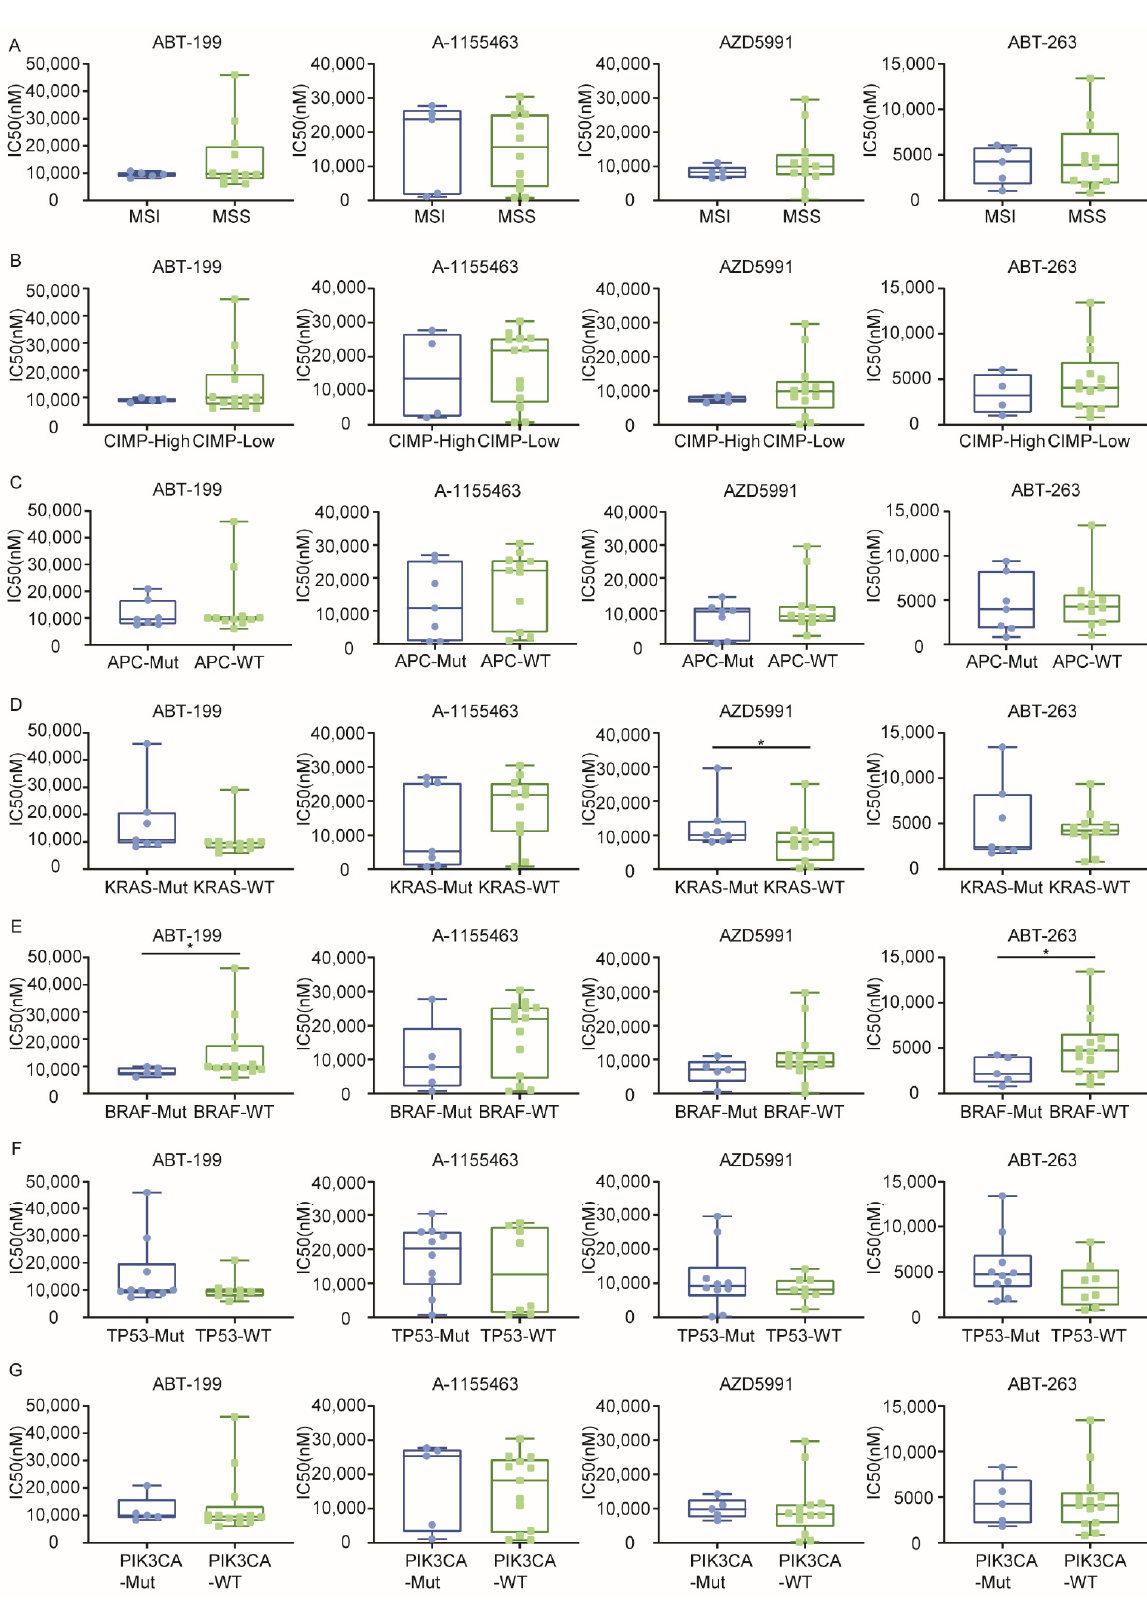
Figure 4. Correlation analysis of IC50 values of four BH3 mimetics and molecular phenotypes in CRCs. ( A ) Microsatellite instability MSI, MSI microsatellite instable; MSS: Microsatellite stable; ( B ) CpG island methylator phenotype CIMP, CIMP- high: High CpG island methylation; CIMP-low: Low CpG island methylation; ( C – G ) Mutation: Mut: Mutant; WT: Wild type; *: p < 0,05; Mann-Whitney test (one-tailed).